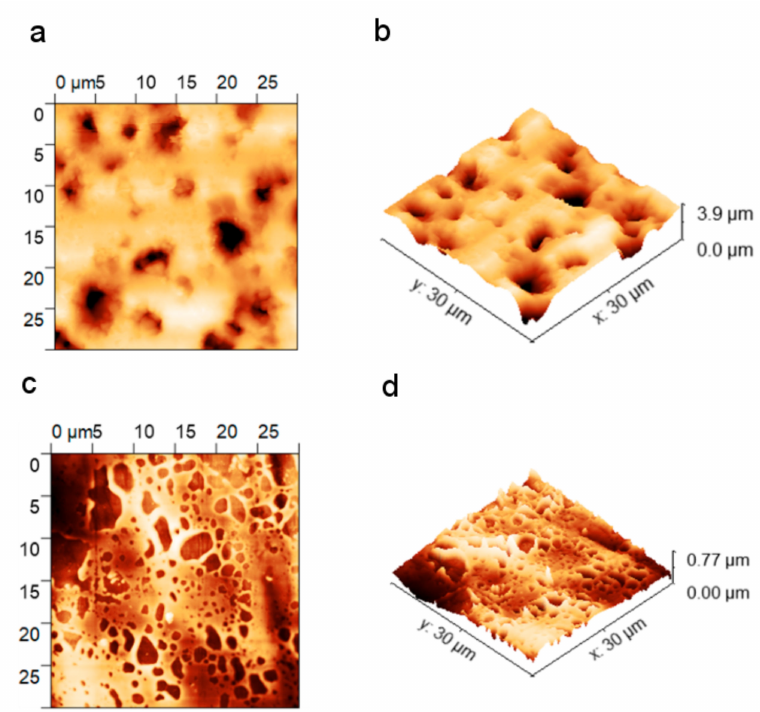
Figure 6. AFM images of the RR-P3HT sensing layer measured on a laminate: the polymer surface ( a ) and 3D-AFM view ( b ); and on metallization: the polymer surface ( c ) and 3D-AFM view ( d